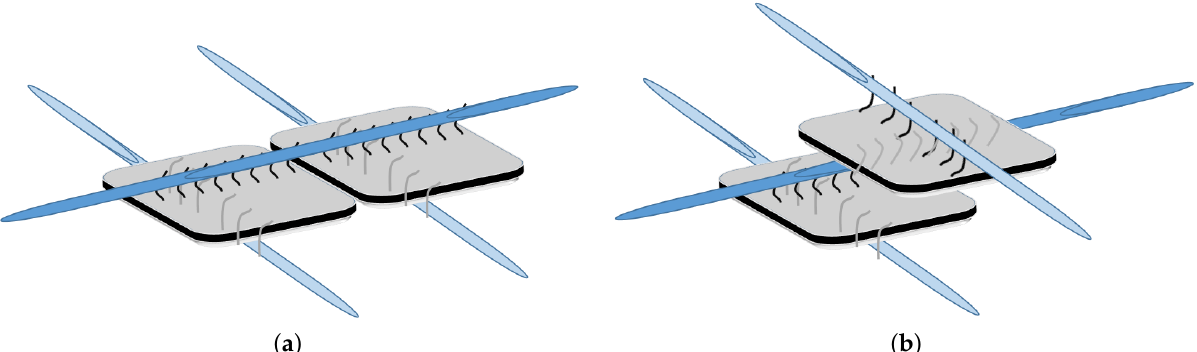
Figure 2. Possible origami positioning along a fibril: ( a ) both origamis are positioned on the same side of the fibril, in which case a minimum (one-origami wide) inter-fibril gap has to be present, and ( b ) the origamis are positioned on opposite sides of the fibril, in which case, in between two parallel fibrils, there could be almost no space at